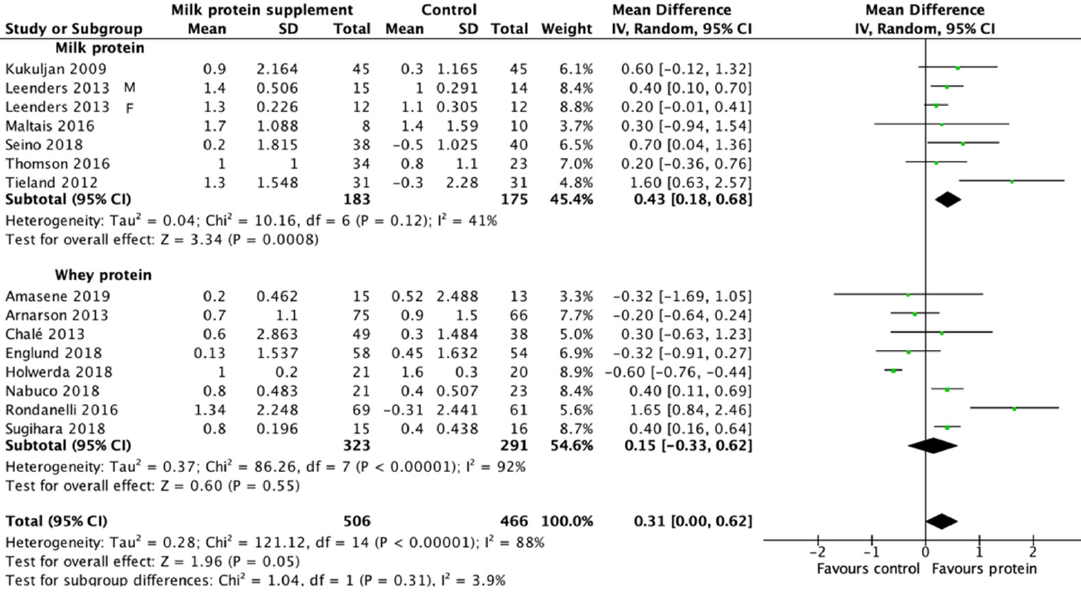
Figure 6. Forest plot for the differences in RT-induced LBM/FFM gain between consuming milk-based protein supplements and control supplements considering the subgroup analysis of protein supplementation type.